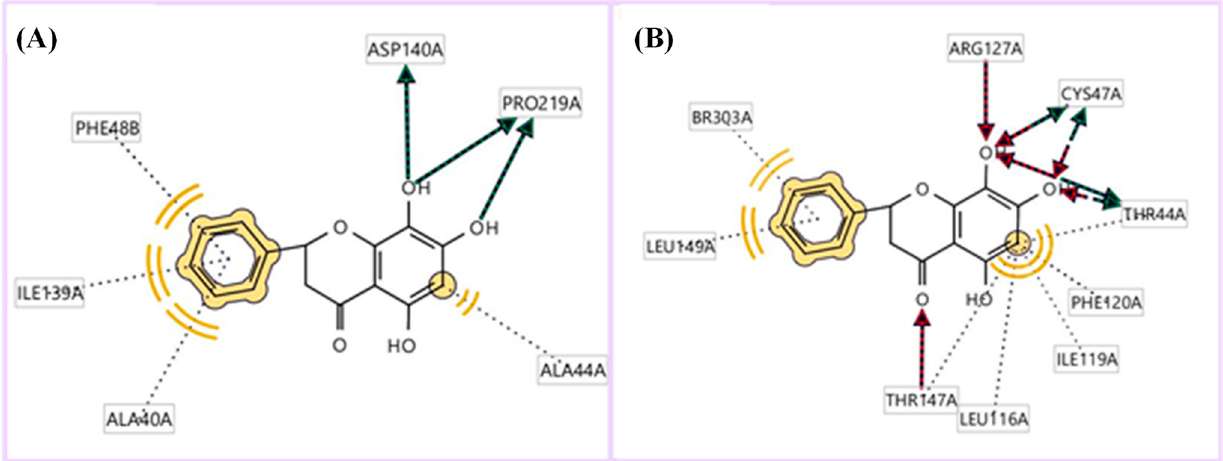
Figure 8. LIGPLOTs showing interacting residues of ( A ) tyrosinase complex and ( B ) human perox- iredoxin 5 with 5,7,8-trihydroxyflavanone. Red arrow dotted lines, HBAs; green arrow dotted lines, HBDs; yellow lines, H interactions.